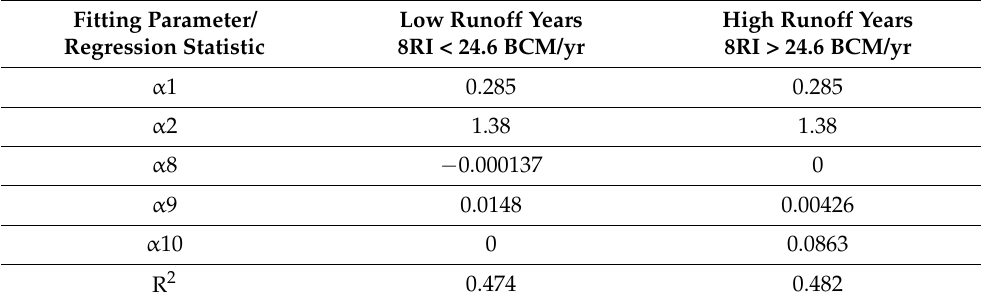
Table 6. Model fitting parameters and regression statistics for Equation (4): adjusted relationships